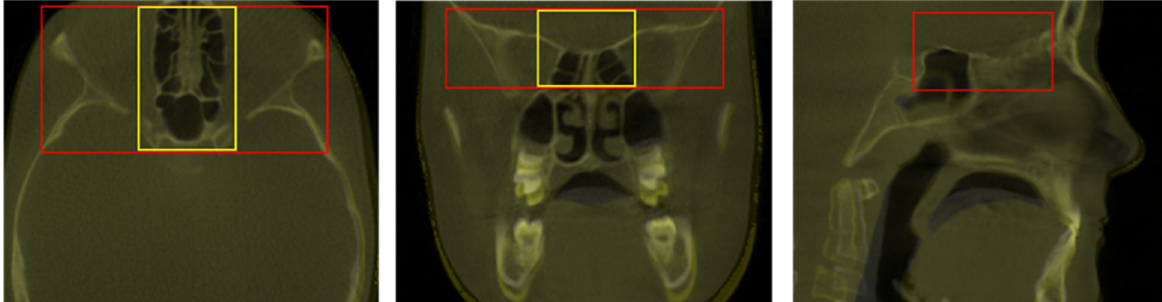
Figure 1. Definition of the Total Anterior Cranial Base area (TACB) (in red) and the Extended Middle Anterior Cranial Base area (EMACB) (in yellow) depicted on T0–T1 volumes, following TACB superimposition. On the right image, the EMACB frame is not visible because it is identical to the one of TACB.